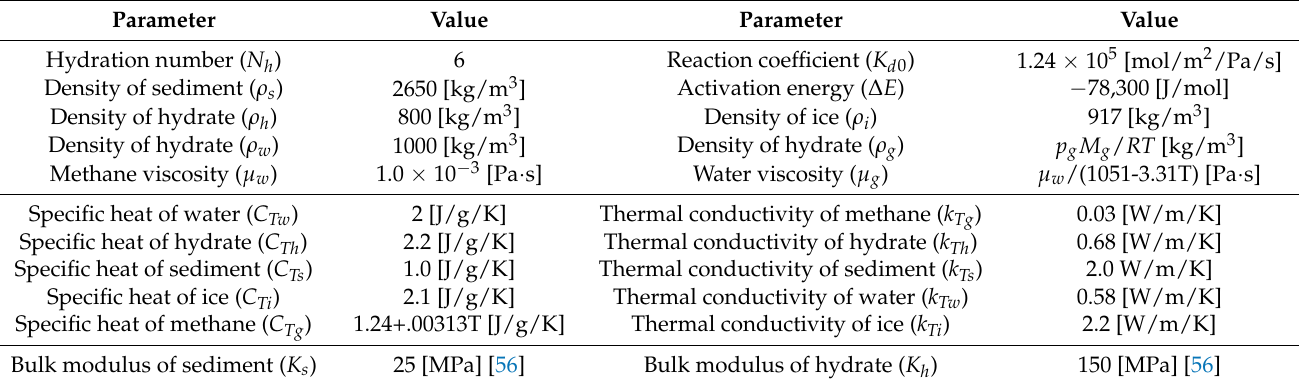
Table 1. The basic parameters of the model used in this